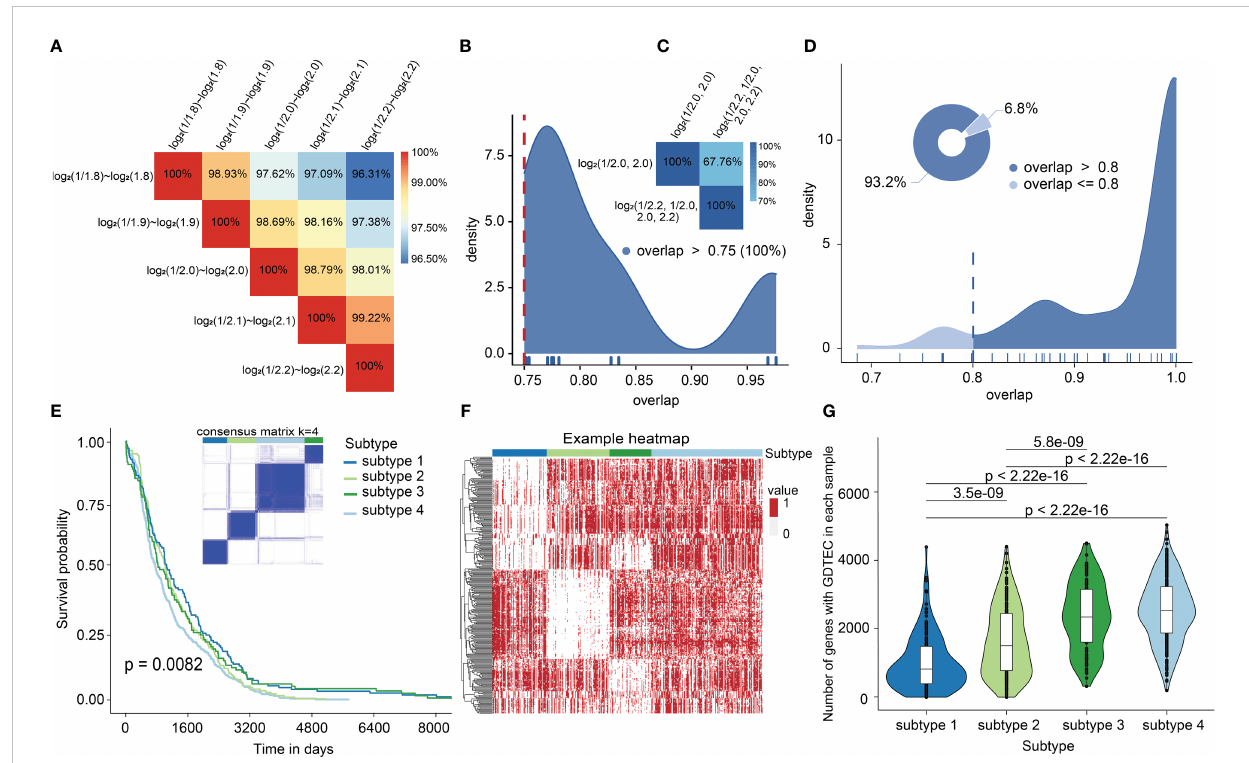
FIGURE 1 (A) The overlap of GDTEC matrices generated under different LFCs. (B) Overlap rate of patients in the clustering results obtained based on different LFCs. (C) Overlap of patients in the clustering results obtained based on multilevel LFC score assignment. (D) The coincidence rate of the patients among the clustering results. (E) Kaplan-Meier curves of the overall survival (OS) among the four subtypes in the TCGA cohort. (F) Hierarchical clustering heat map of 299 genes with GDTEC features ( ‘ 1 ’ indicates GDTEC expression, and ‘ 0 ’ indicates no GDTEC expression). (G) The number of genes with GDTEC features in the four subtypes, out of 14,749 genes in the multi-omics fusion